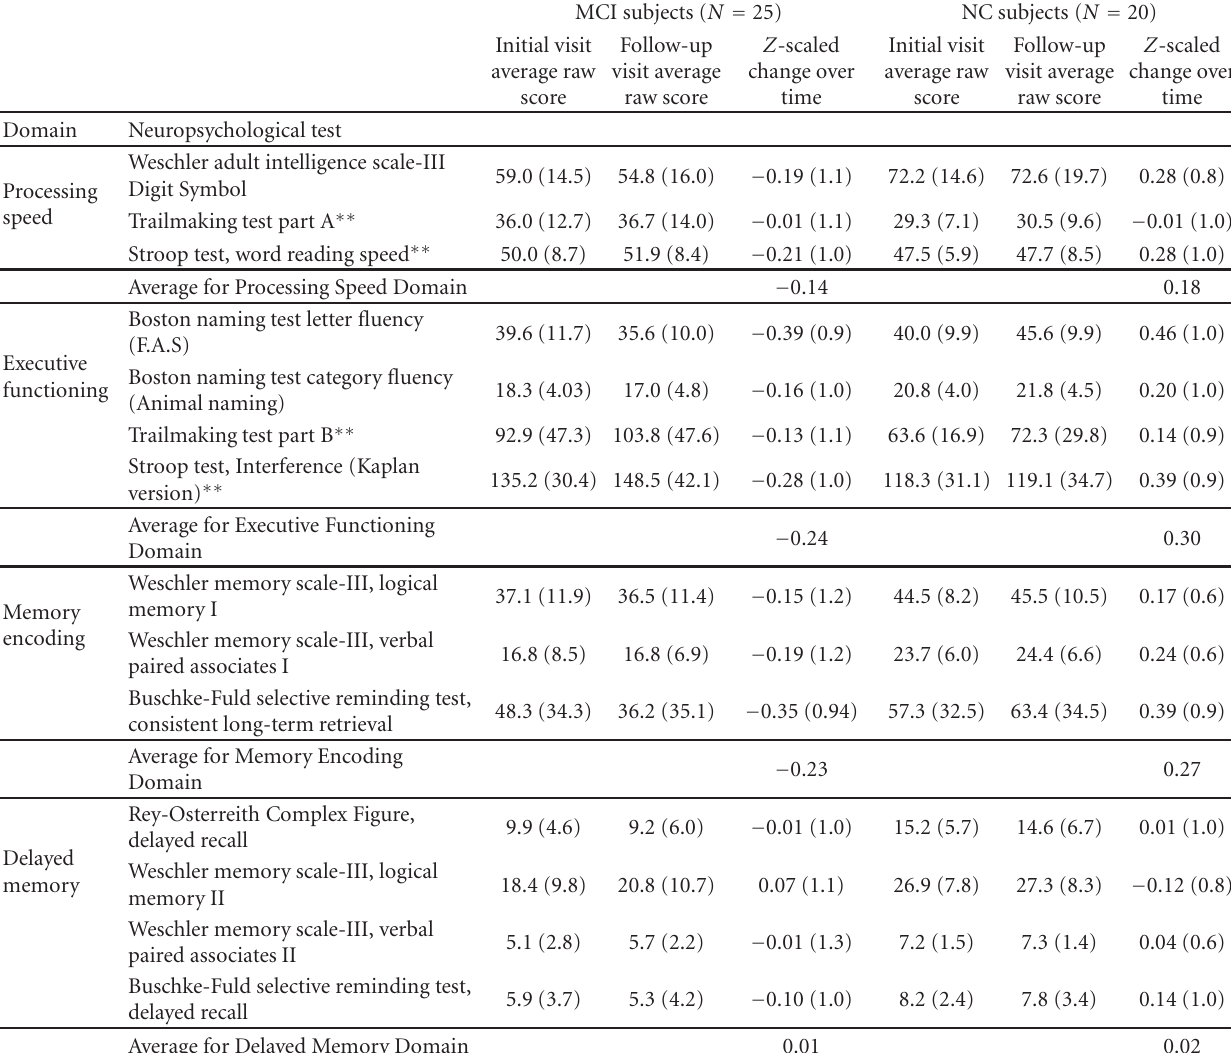
Table 2: Neuropsychological test performance: MCI and NC subjects scores on individual neuropsychological tests. Averages across specified tests provide Domain scores. Both initial and follow-up raw scores, with standard deviation in parentheses, as well as average Z scores are provided for both groups.